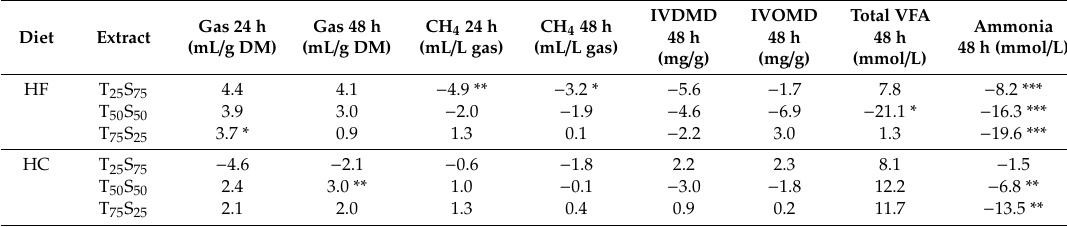
Table 5. Associative e ff ects † of the combinations between plant extracts rich in T and S added to the HF or HC